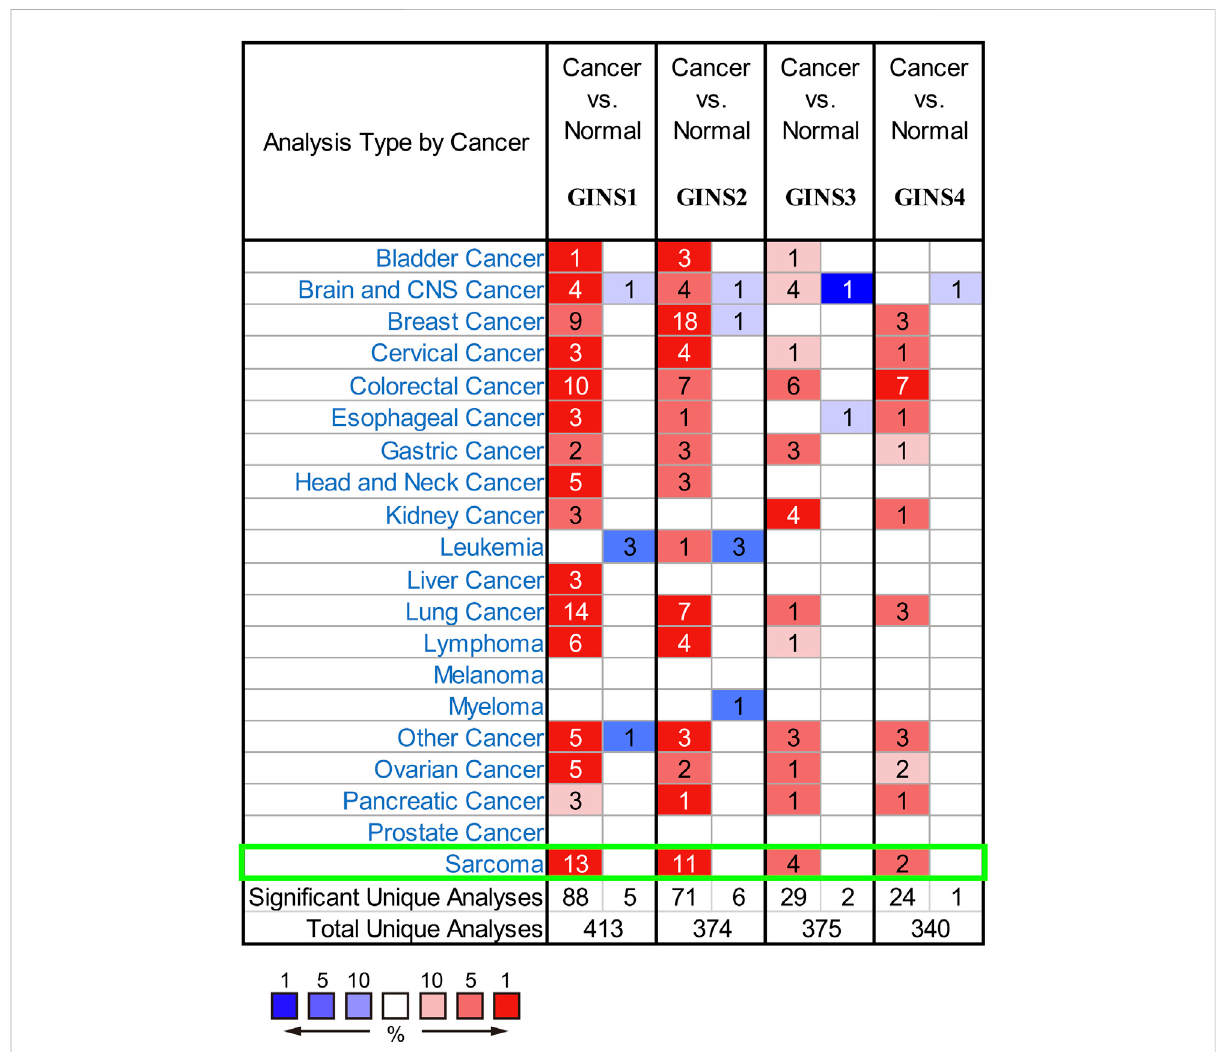
FIGURE 2 The mRNA transcription of GINS subunits in SARC in Oncomine. Upregulated expression is shown in red and downregulated expression is shown in blue. The values in the cells represent the number of datasets that meet the